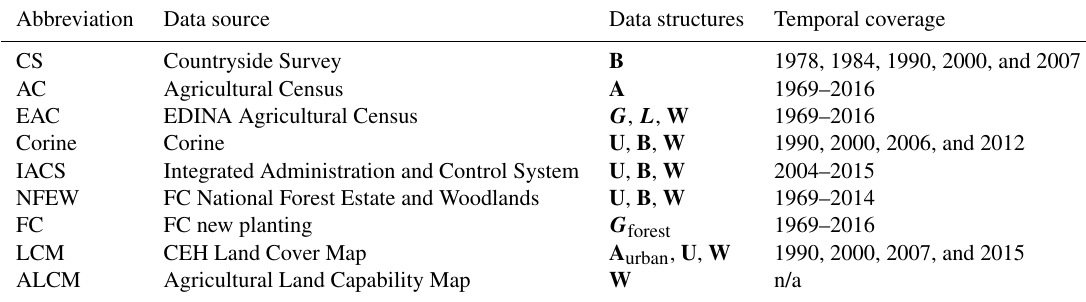
Table 1. Data sources assimilated in the estimation of land-use change in